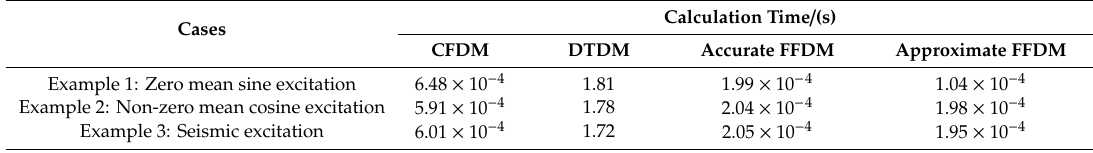
Table 4. Comparison of calculation